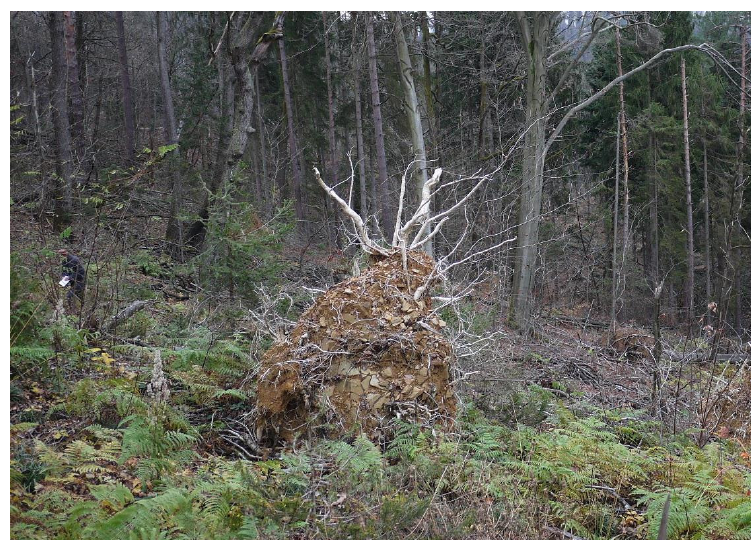
Figure 3. Over the long term, treefall pit-and-mounds facilitate tree diversity through enhancing microsite topography and soil variability. However, for the first few years, regeneration may be delayed by erosion.